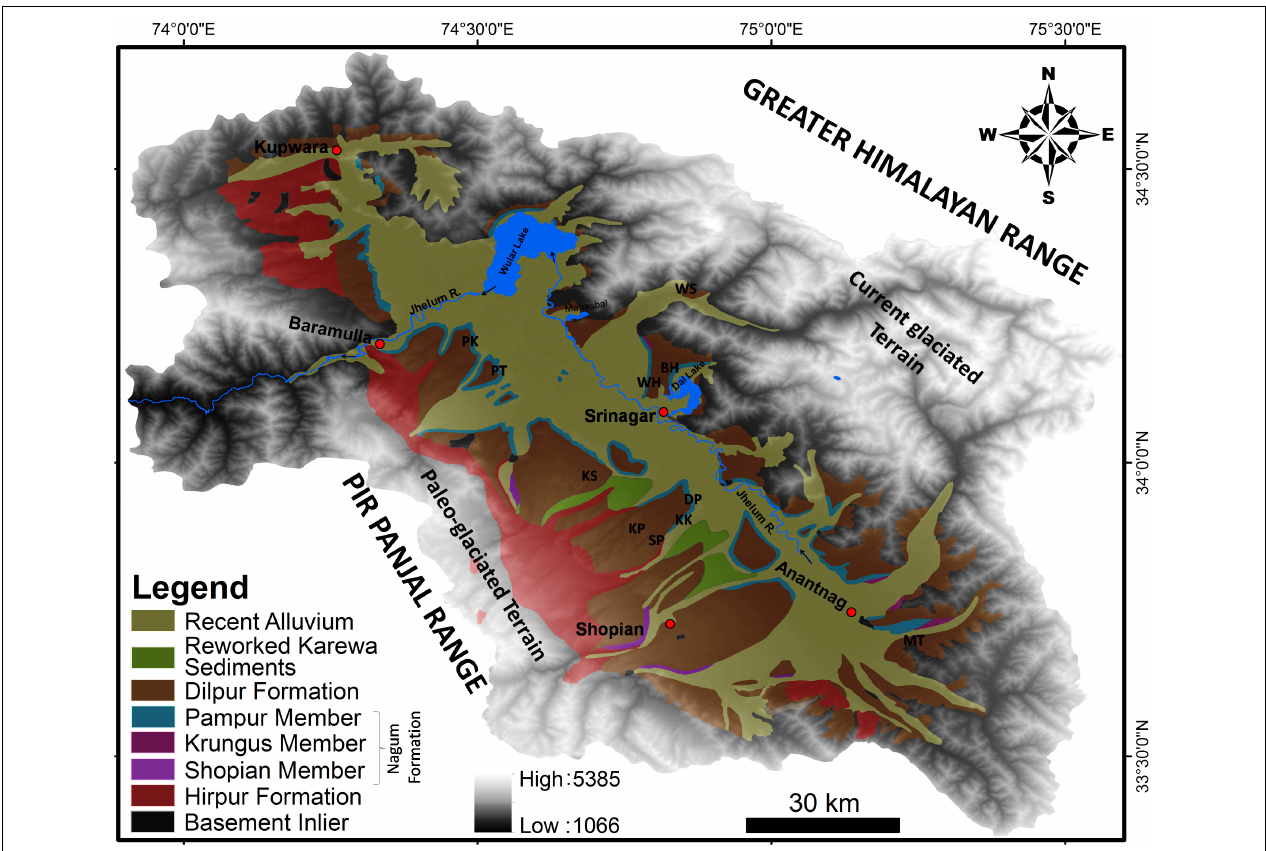
FIGURE 2 | Spatial distribution of various sediments of the Karewa Group in the Kashmir Valley after Bhatt (1982). Abbreviations MT, SP, KS, PT, PK, DP, KP, KK, BH, WH, and WS indicate the localities Mattan, Shankerpora, Khan Sahib, Pattan, Putkhah, Dilpur, Karapur, KhanchiKol, Burzahom, Wanihama, and Wuyil Sind, respectively. The Dilpur Formation represents loess and loess like sediments. The altitude is derived from SRTM (DEM; Farr et al.,